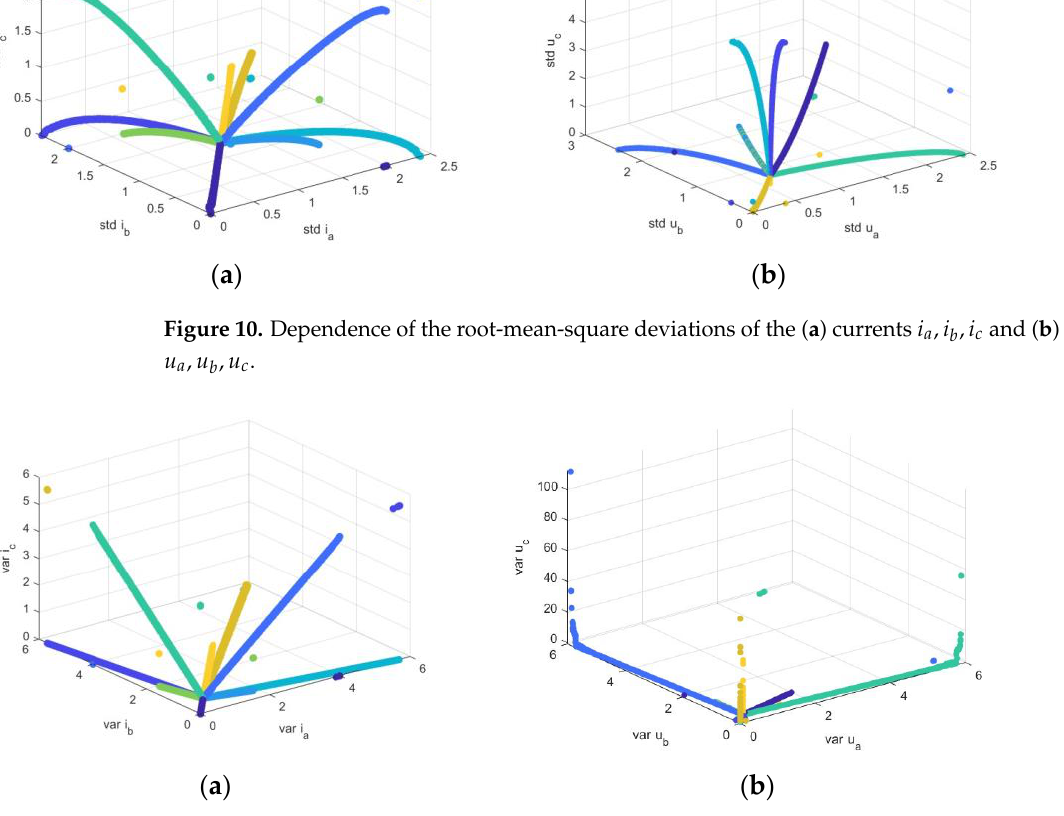
Figure 11. Dependence of variation of the ( a ) currents 𝑖 𝑎 , 𝑖 𝑏 , 𝑖 𝑐 and ( b ) voltages 𝑢 𝑎 , 𝑢 𝑏 , 𝑢 𝑐 .